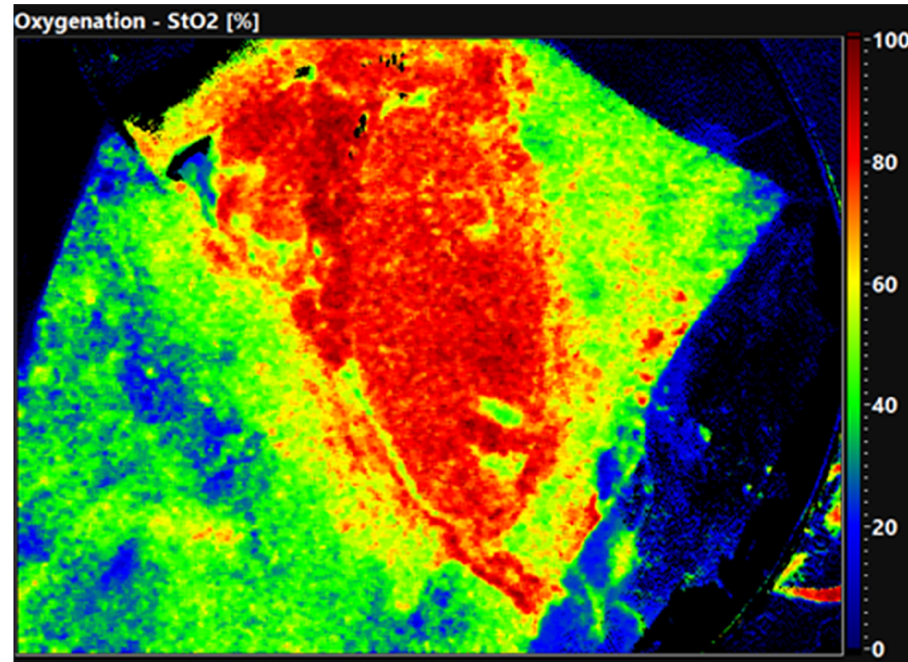
Figure 2. False-color image of a primary functioning kidney 30 min after reperfusion. The red color displays a high oxygen saturation (80–100%).